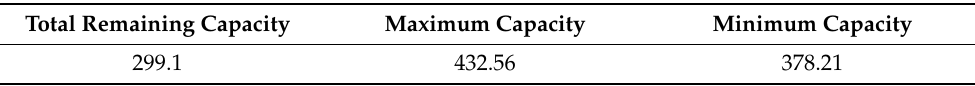
Table 10. Total remaining capacity and maximum and minimum capacity required for harmonic mitigation (kW).